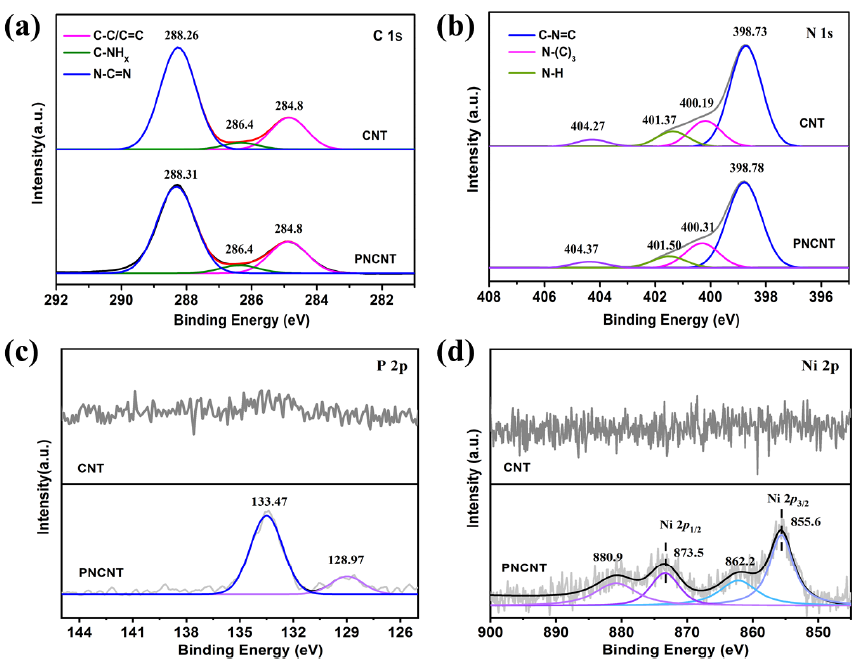
Figure 5. The high-resolution C 1s ( a ), N 1s ( b ), P 2p ( c ) and Ni 2p ( d ) XPS spectra of CNT and PNCNT samples.